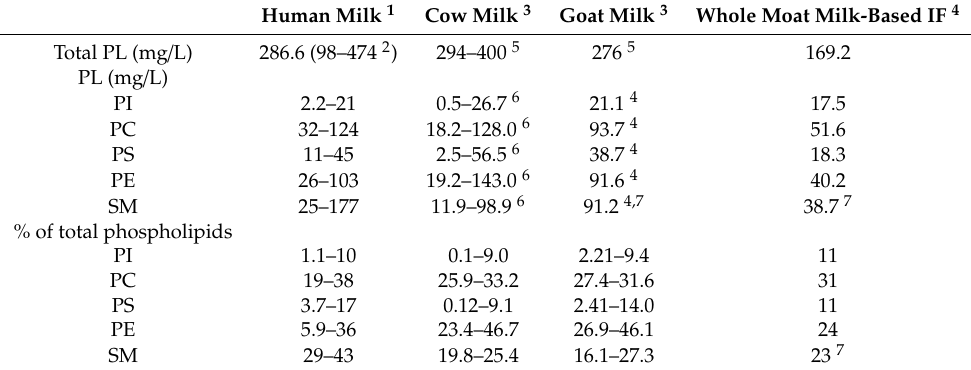
Table 4. Total phospholipid concentration (mg / L) and percentage of phospholipid species (% of